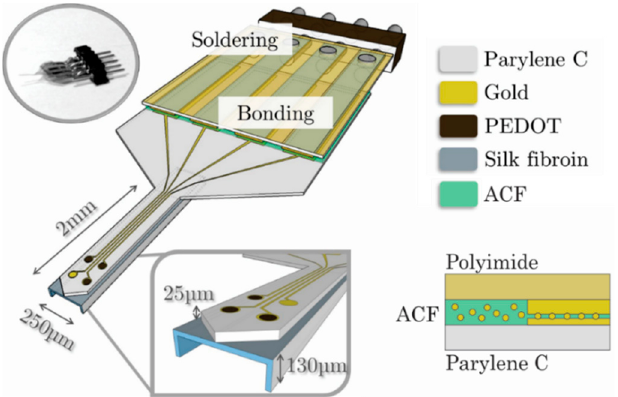
Figure 10. Schematic representation of a Parylene-based neural probe consisting of three PEDOT (poly(3,4-ethylenedioxythiophene))-nanostructured electrodes and one gold electrode as control. The device is anisotropic conductive film (ACF) bonded onto a flexible polyimide cable, which is then soldered onto a pin connector adapted to the wireless acquisition system. The cross-section shows bond pads from the device bonded via ACF to the bond pads of the polyimide cable. Reprinted from [88] with permission from Elsevier.